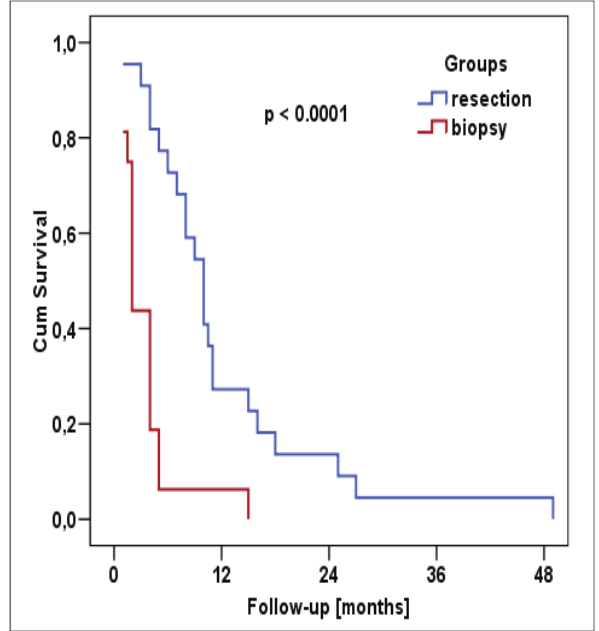
Fig. 1. The comparison of OS between the resection and the biopsy